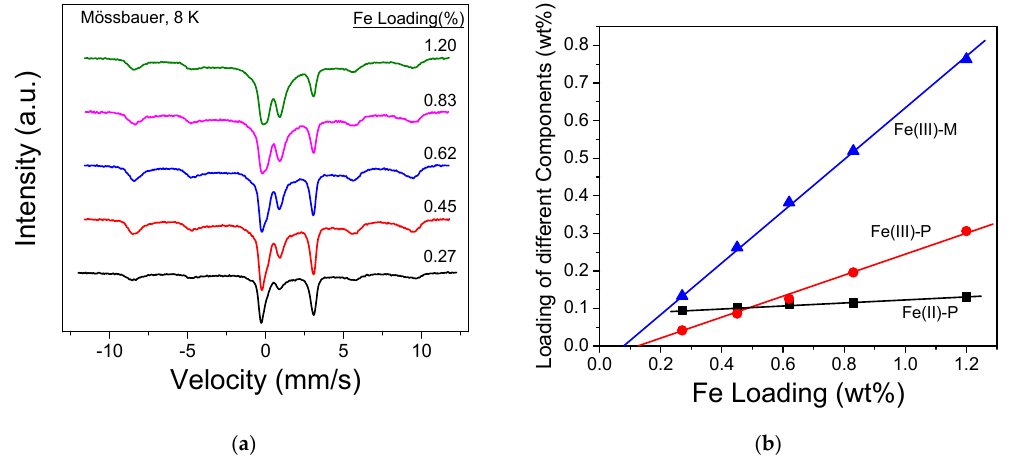
Figure 7. ( a ) Mössbauer spectra of the ambient 57Fe / SSZ-13 samples measured at 8 K. Spectra are shifted vertically and displayed with different colors, and Fe loadings are marked adjacent to the spectra. ( b ) Loadings of the three Fe components determined from Mössbauer spectroscopy as a function of total Fe loading. Reprinted with permission from [28]. Copyright © 2016 American Chemical Society.